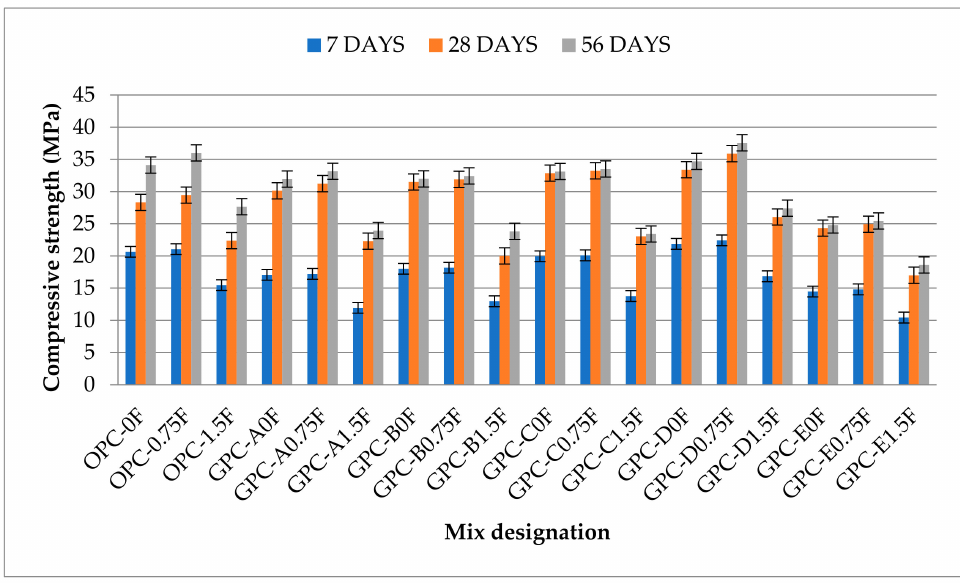
Figure 6. The compressive strength values of GPC and OPC mixes.